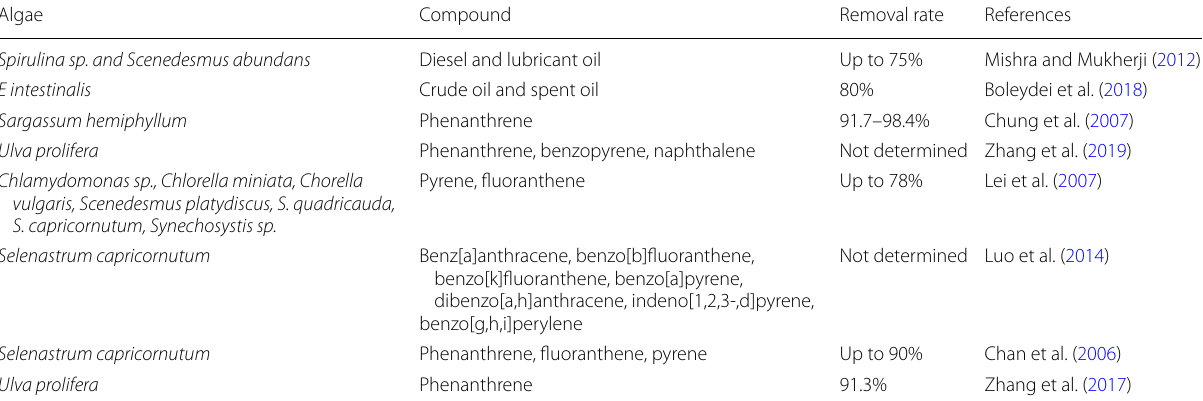
Table 1 Use different types of algae-derived adsorbents in the removal of petroleum pollutants Algae